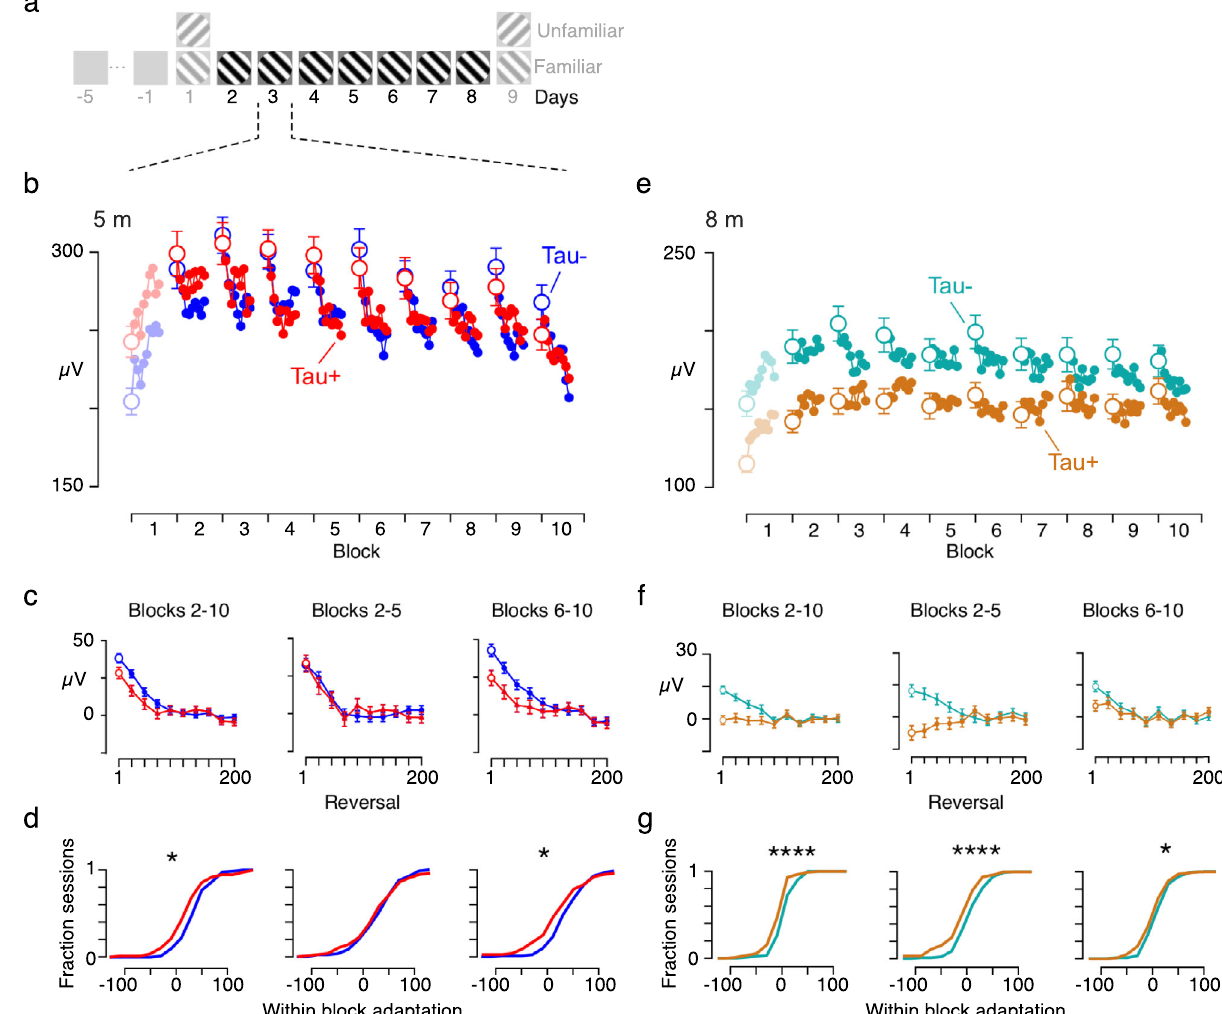
Fig. 4 Short-term visual plasticity is reduced in rTg4510 mice expressing mutant tau. a We measured intra-day effects on experimental days 2 – 8. On each day 10 blocks of the familiar stimulus were presented, each consisting of 200 phase reversals and separated by 30 s of a homogenous grey screen. b Average VEP amplitude for days 2 – 8 as a function of block number for 5-month old Tau − (blue, n = 12) and Tau + (red, n = 11) mice. The VEP amplitude was calculated from non-overlapping averages of 20 reversals. With the notable exception of the fi rst block, VEPs showed a reduction of responses within each block, consistent with classic sensory adaptation effects. c Average VEP responses for blocks 2 – 10 (Left) and separately for blocks 2 – 5 (Middle) and blocks 6 – 10 (Right) on days 2 – 8, for Tau − ( n = 12) and Tau + ( n = 11) animals. VEP amplitudes within each block were normalised by subtracting the average VEP amplitude of the last 100 reversals for that block. The within block amplitudes (at a resolution of 20 reversals) were then fi t with a decaying exponential function of fi xed τ = 8.4 reversals (see “ Methods ” ), and the amplitude of the exponential was extracted. d Cumulative histograms of these fi tted amplitudes for Tau + (solid red) and Tau − (dotted blue) mice, normalised by the total number of sessions for each cohort. At 5 months, Tau + animals showed reduced within-block adaptation compared to Tau − mice for blocks 6 – 10, but not for blocks 2 – 5. The asterisks indicate a signi fi cant difference between the distributions (Students t-test; **** p < 10 − 4 , * p < 0.05). e – g Same as b – d for 8-month old animals ( n = 13 Tau − , n = 13 Tau + ). The within-block adaptation is reduced for Tau − mice at 8 months compared to 5 months. Tau + mice showed no suppressive adaptation effect for either early or late blocks. Error bars represent the mean ± SEM. The source data underlying this fi gure are available in Supplementary Data